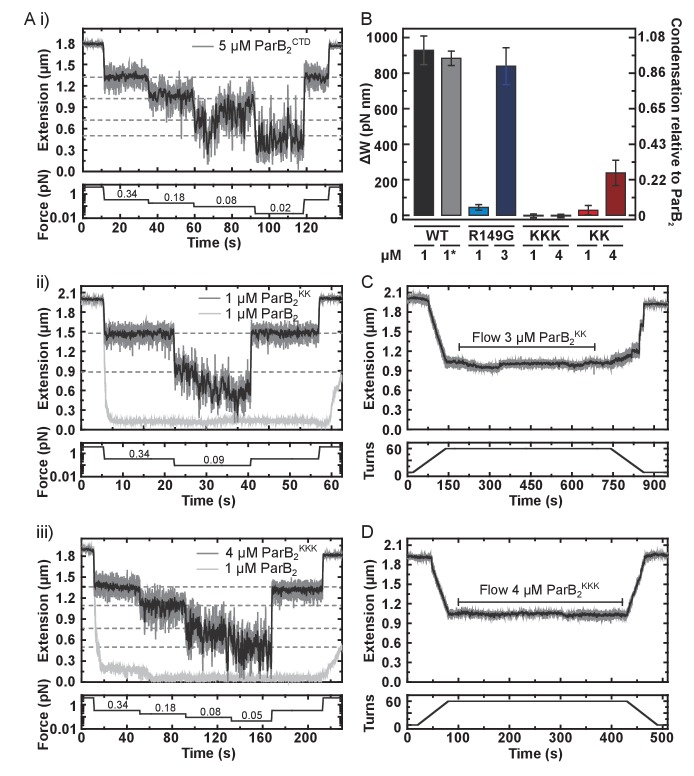
DNA binding by the CTD is required for efficient DNA condensation in vitro.(A) Representative traces of condensation assays monitored by magnetic tweezers. The expected DNA extension in the absence of ParB at each force is indicated by the dashed lines. (i), (ii) and (ii) use CTD, ParBKK and ParBKKK, respectively. (B) A comparison of the work produced by full length ParB variants in condensing DNA. Errors are standard error of the mean. * indicates this experiment used nsDNA rather than parS-containing. (C) Representative trace of a ParBKK plectoneme stabilisation assay showing hysteresis of DNA extension upon DNA rewinding. (D) Representative trace of a ParBKKK plectoneme stabilisation assay showing no hysteresis upon DNA rewinding.